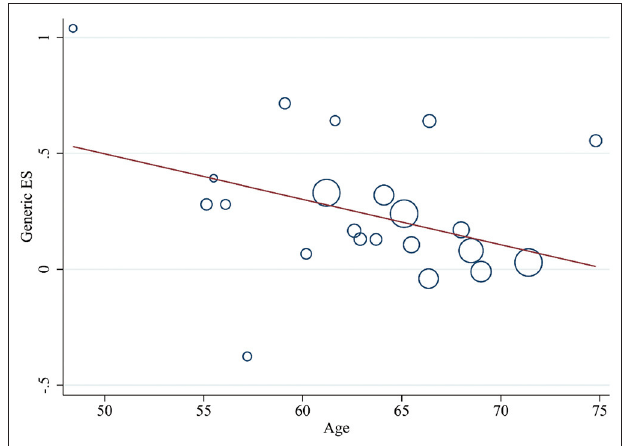
FIGURE 6 | Funnel plots representing standard error (SE) and pooled effect size in the effect of PA on cognitive performance. CI, confidence interval; PA, physical